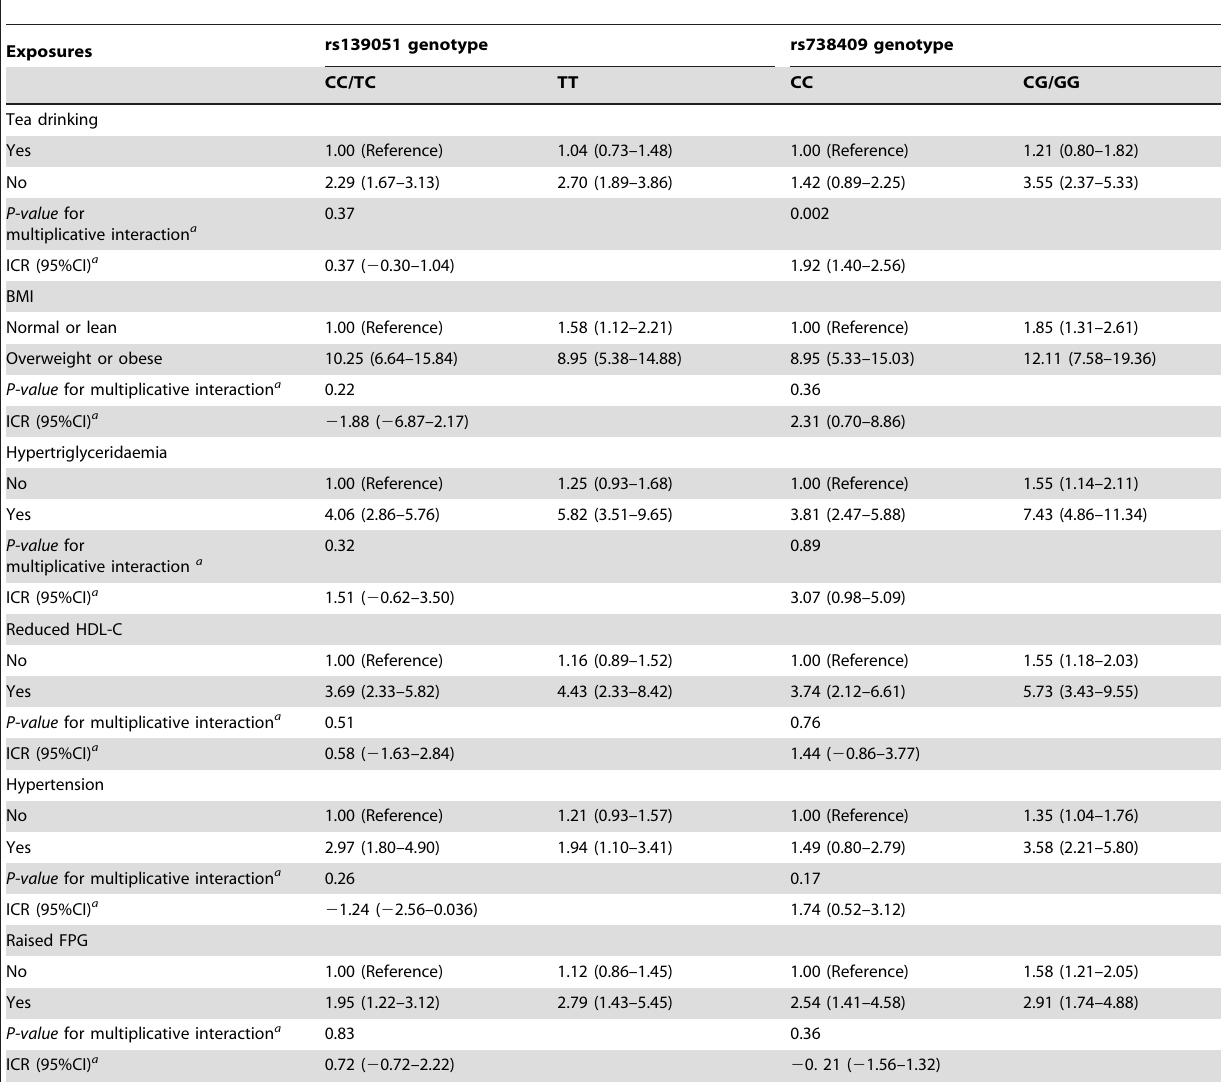
Table 4. Combined effects a of PNPLA3 polymorphisms and environmental and ‘internal’ exposures on the risk of